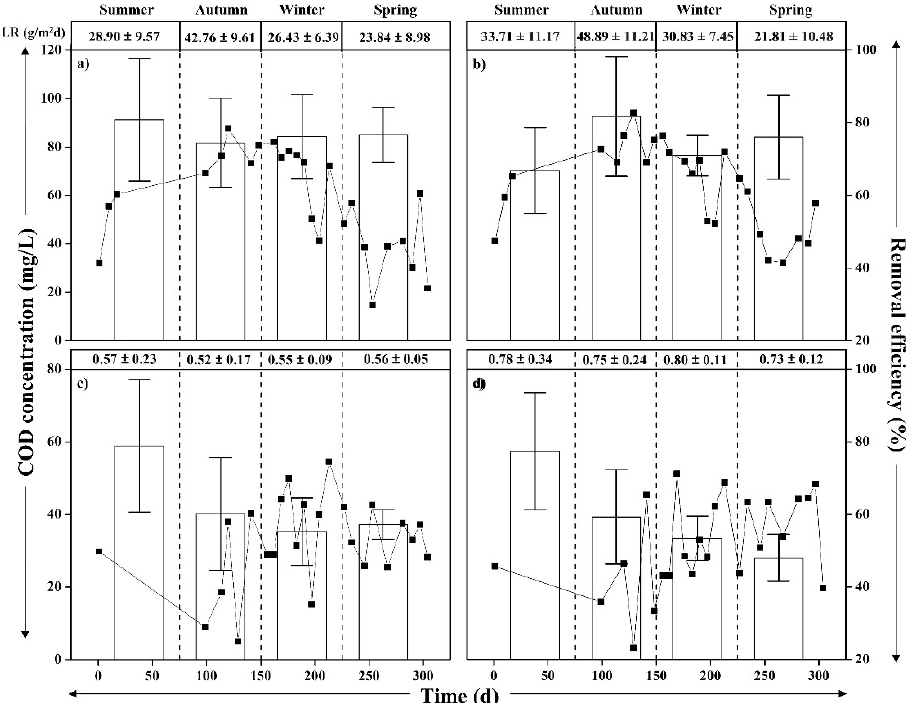
Figure 3. Average of effluent COD concentration (bars) and removal efficiencies (points): ( a ) VSSF 1: ( b ) VSSF 2: ( c ) HSSF 1; and ( d ) HSSF 2. OLR: organic loading rate. ( b ) VSSF 2: ( c ) HSSF 1; and ( d ) HSSF 2. OLR: organic loading